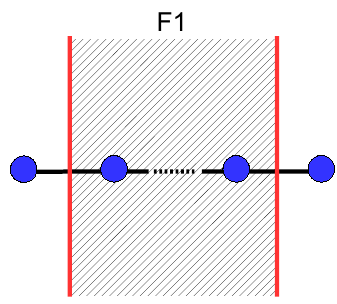
Figure 23 . A full F1 stretched between the two D5s and crossing the D3 segments, realizing (cid:0) W f W or ( (cid:0) 1) M +1 X 1 X 2 (cid:1) (cid:1) (cid:1) X M X M +1